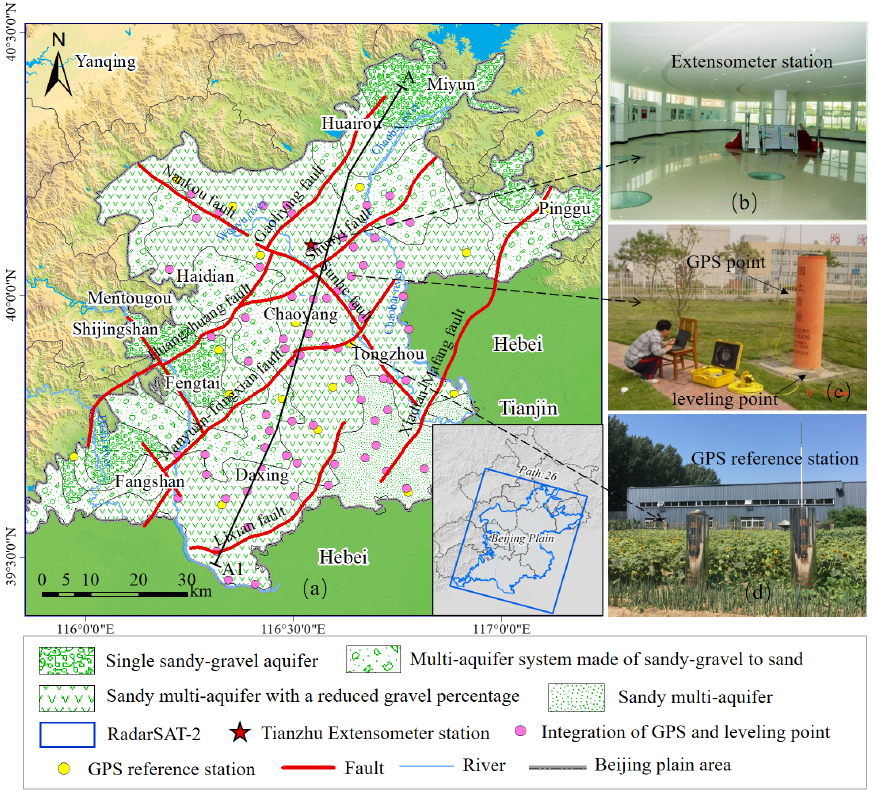
Figure 1. ( a ) The location and geological conditions of the Beijing Plain. The position of the Tianzhu extensometer station, InSAR coverage, GPS and leveling integrated points, and CORS stations are provided. Hydrogeologic cross-section of Beijing alluvial-proluvial fan along the north to south A–A1 traced in Figure 2. ( b ) Tianzhu Extensometer Station. ( c ) GPS and leveling integrated point and GPS measurement. ( d ) The continuous operation reference station of GPS(CORS).